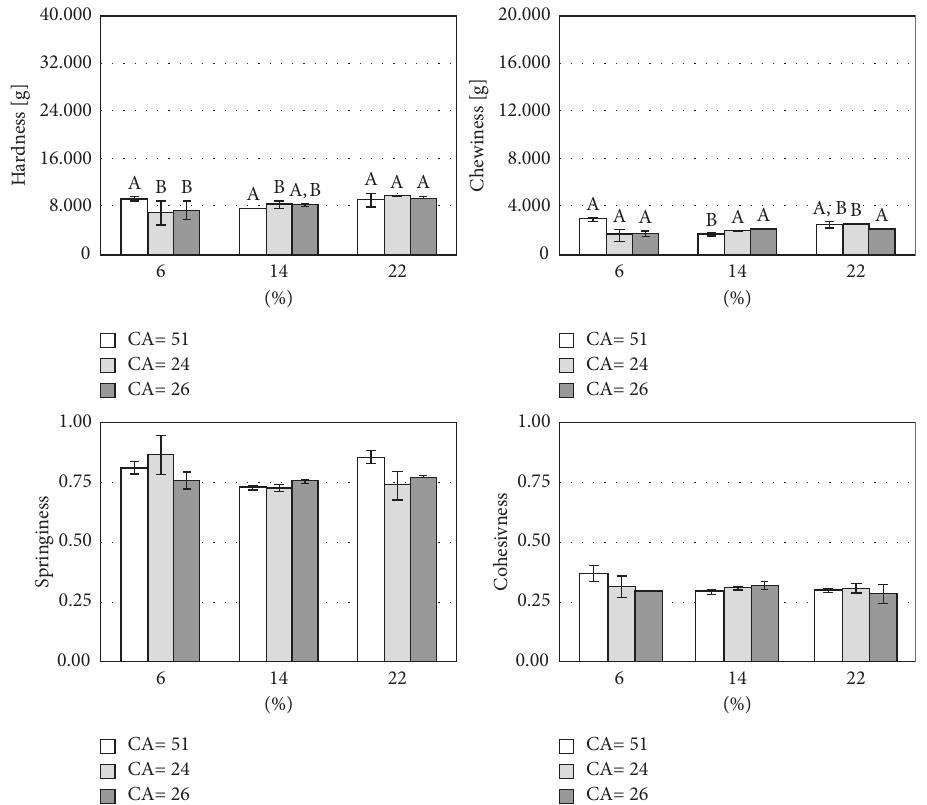
Figure 7: Texture profle analysis parameters for recipe R 2 ( X -axes: overstufng percentage). Means between each same split-plot pa- rameters combination ± standard error. Diferent uppercase letters indicate that the average values difer signifcantly ( P < 0 . 05) by